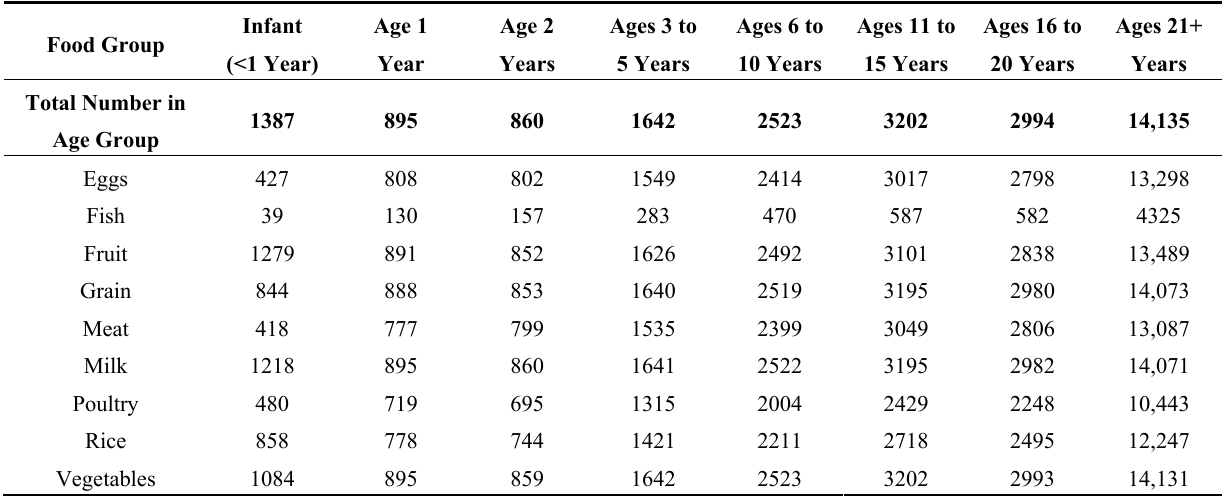
Table A3. Number of individuals in each age group, who had any (non-zero) consumption from each food group (NHANES 2003–2008).